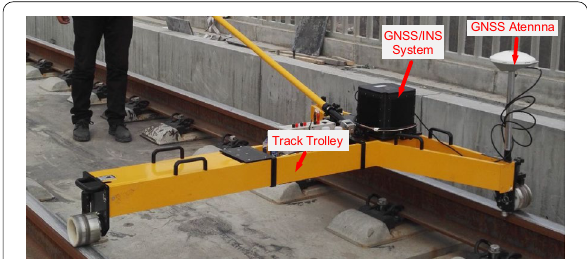
Fig. 10 Railway track geometry measuring trolley (TGMT) based on an aided